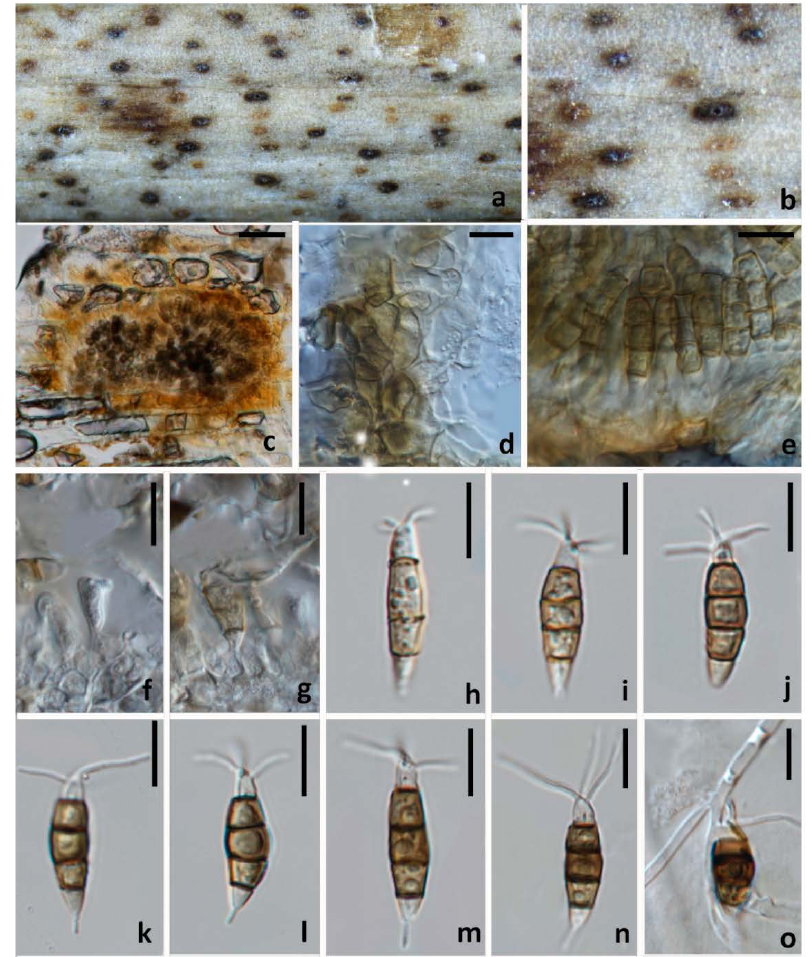
Figure 5. Neopestalotiopsis mianyangensis (HKAS 123211, holotype) ( a , b ) Appearance of conidiomata on the host. ( c ) Transverse section of conidioma. ( d ) Conidiomatal wall. ( e ) Sporodochium. ( f , g ) Conidiogenous cells and conidia. ( h – n ) conidia. ( o ) Germinated conidium. Scale bars: ( c ) = 50 µ m, ( d – o ) = 10 µ